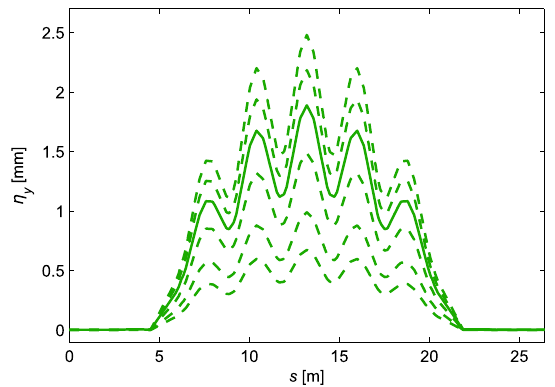
TABLE I. Normalized skew quadrupole gradient k in m − 2 , generated by auxiliary coils on the magnets used for the presented SCVDBs. The effective length of each magnet is 0.1 m. The vertical emittance E given here is created in the ideal lattice (i.e. II without magnet errors or FIG. 4. SCVDB scaling in the ideal lattice of Case 3. Indicated with a solid line is the vertical dispersion that creates 6.6 pm rad of vertical emittance in the ideal lattice and on average 7.8 pm rad when including imperfections. The dashed lines show the vertical ¼ 0 . 9 , 1.8, 4.1, 8.9 dispersions of scaled SCVDBs that create E II and 11.4 pm rad in the ideal lattice, respectively.